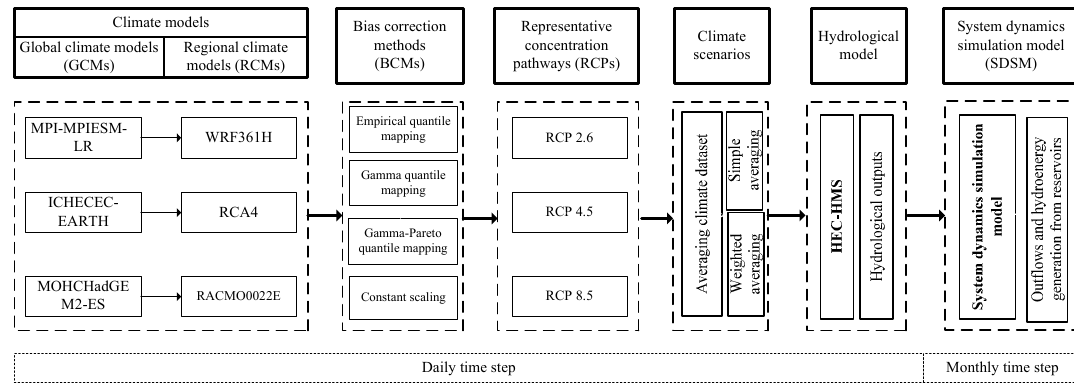
Figure 2. The climate change impact analysis process used in the study.